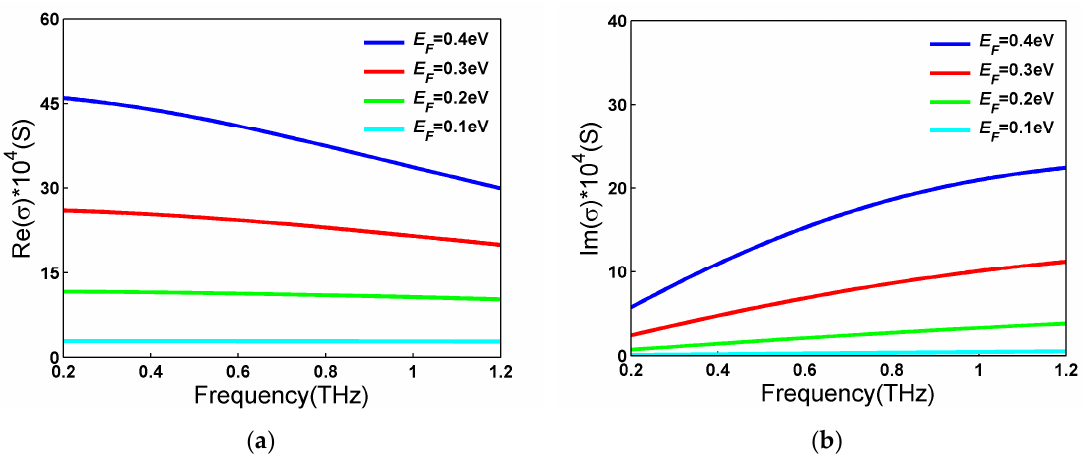
Figure 2. The frequency dependent graphene conductivity under different Fermi energy: ( a ) real and ( b ) imaginary parts. The Fermi energy varied from 0.1 eV to 0.4 eV.